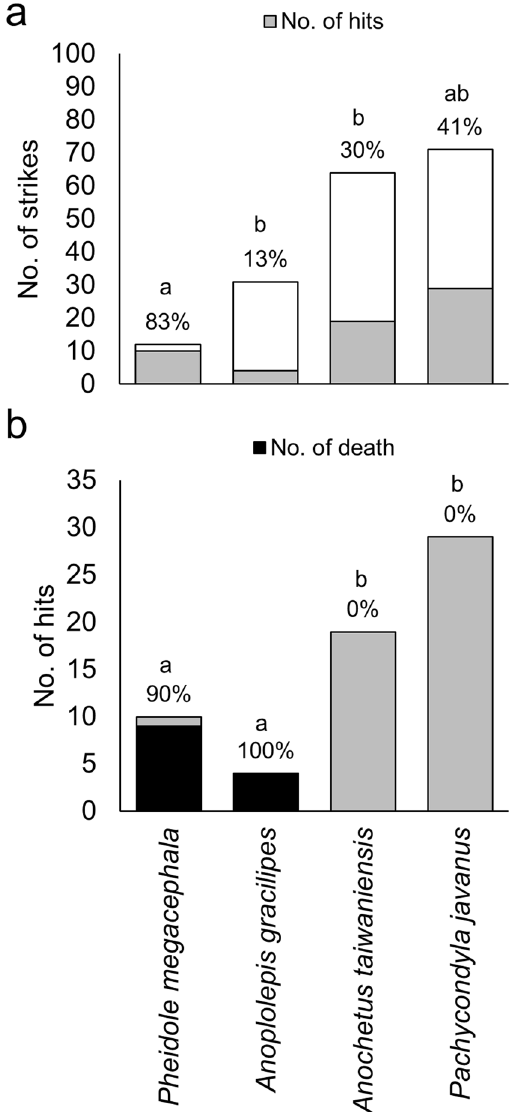
Figure 4. Defensive performance of mandibular snaps by probability (values above each bar) of ( a ) hitting and ( b ) killing four predator ant species. Bars with identical letters were not significantly different at p < 0.05 (Fisher’s exact tests with Bonferroni corrections). Termites could not kill their specialist predators Anochetus taiwaniensis and Pachycondyla javanus